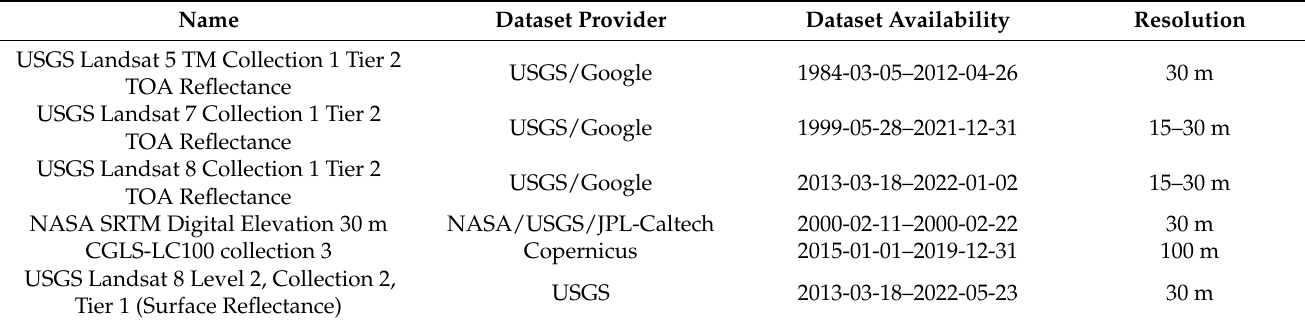
Table 1. Description of datasets included in the